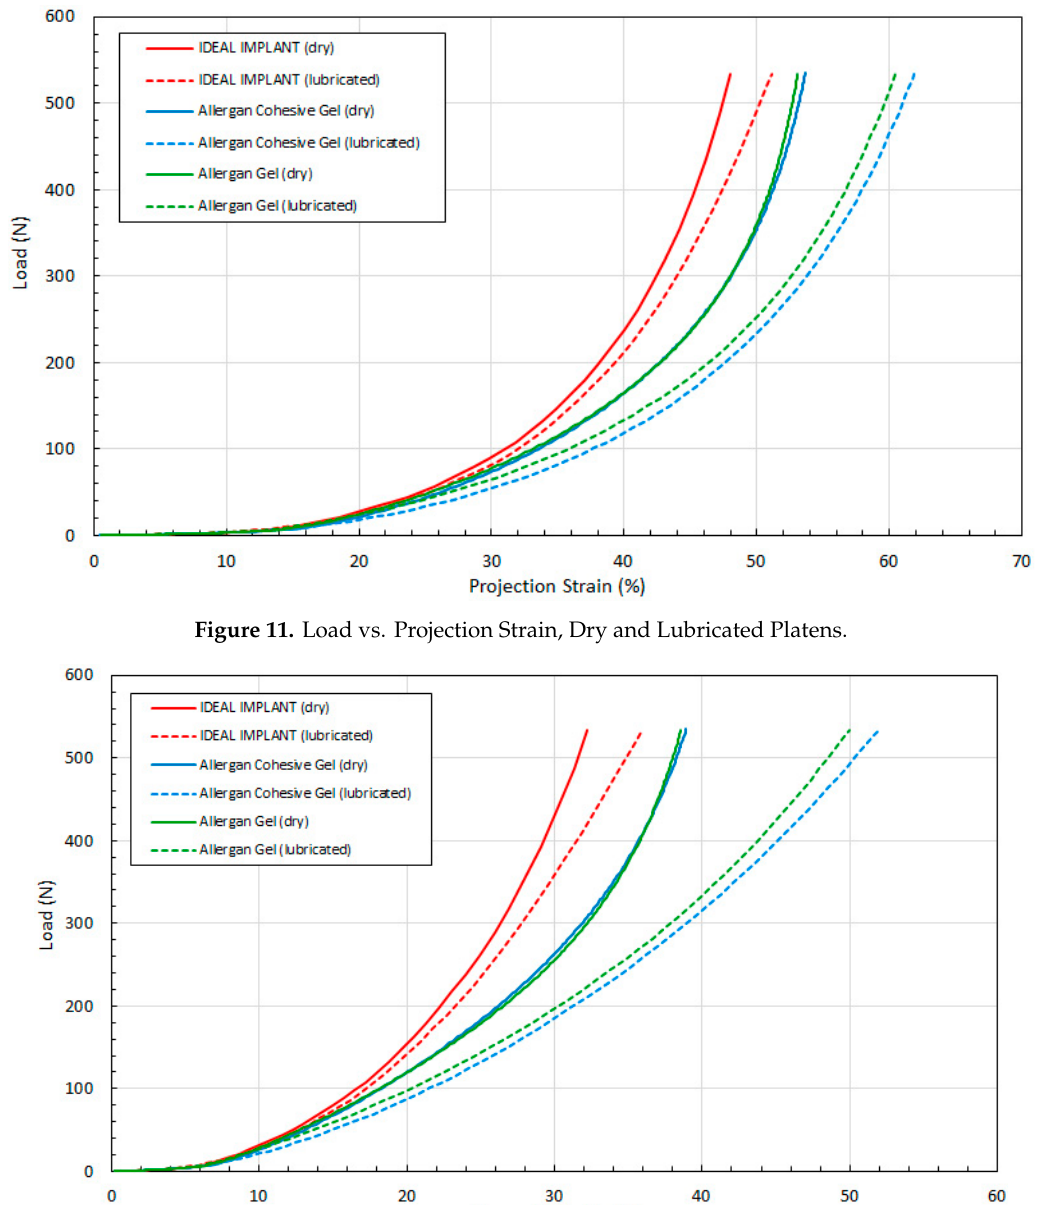
Figure 13. Load vs. Areal Strain, Dry and Lubricated Platens. Several observations are in order. First, all three engineering strains for the IDEAL IMPLANT are less than those for the Allergan cohesive gel and gel implants at a given load. Over the load range of about 100 N to 500 N, the projection strains ϵ H of the gel implants relative to the IDEAL IMPLANT are about 10–15% and 13–22% higher for dry and lubricated platens, respectively. For the same load range, the diametric strains ϵ D for the gel implants relative to the IDEAL IMPLANT are about 6–19% and 24–42% larger for dry and lubricated platens, respectively. And, for the same load range, the areal strains ϵ A for the gel implants relative to the IDEAL IMPLANT are about 5–25% and 40–55% larger for dry and lubricated platens, respectively. Hence, the shape change due to compression is less for the IDEAL IMPLANT, especially for loads exceeding about 100 N. The trends in Figures 11– 13 are the same for both dry and lubricated platen data sets, except that the strain values are much larger for the case of lubricated platens. A consequence of these results is that the effect of platen